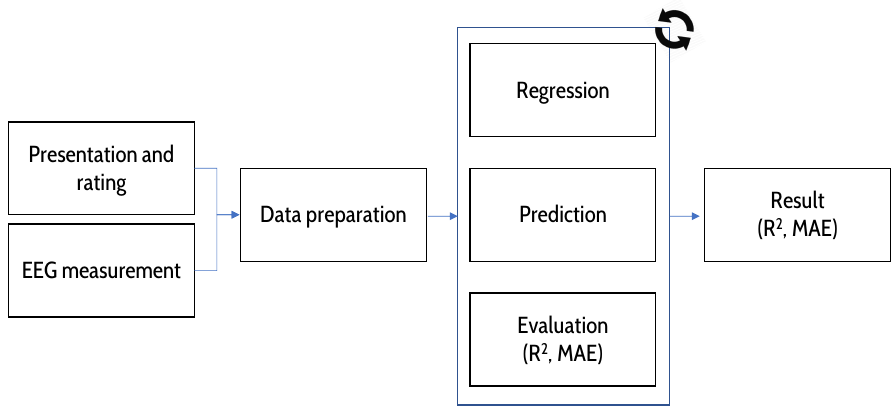
Figure 1. Overview of the methodology for creating and evaluating the Spherical Virtual Reality (SVR) data, as employed in [2]. Initial data gathering through a new set of human subject experiments is followed by data preparations and subsequent prediction